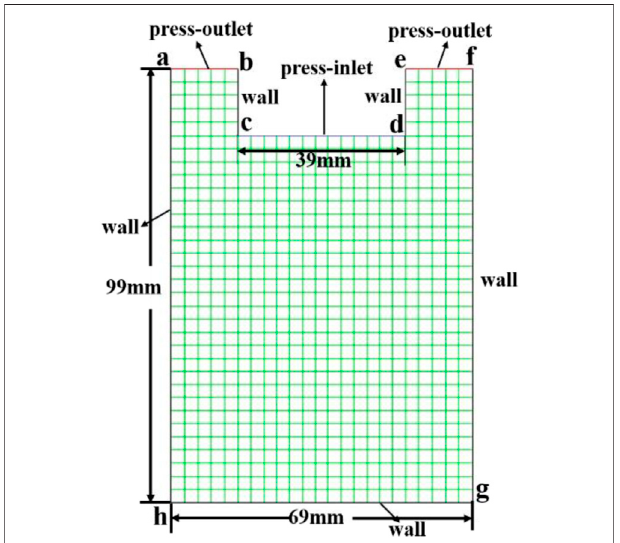
FIGURE 1 | 2D mesh model of the ultrasonic treatment process.